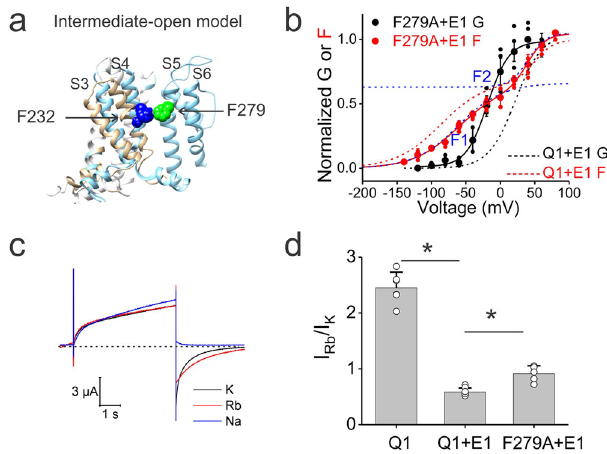
Fig. 4 F279A also allows KCNQ1/KCNE1 to open in the intermediate S4 state. a Overlay of an NMR VSD structure (gray) (PDB: 6MIE) and a cryo-EM structure (blue) (PDB: 6UZZ) of KCNQ1 channels. The NMR structure was suggested to be in the intermediate state and the cryo-EM structure was suggested to be in the fully activated state. F232 (blue) in S4 is close to F279 (green) in S5 in the intermediate VSD conformation. Only S3, S4, S5, and S6 are shown for clarity. b Voltage dependence of currents (black) and fl uorescence (red) from KCNQ1/KCNE1 (dashed lines for comparison) and KCNQ1-F279A/KCNE1 (circles) channels. F1 and F2 indicate the fi rst and second fl uorescence components from KCNQ1- F279A/KCNE1 channels (blue dashed lines). N is shown in Supplementary Table 1. c Current traces from oocytes expressing KCNQ1-F279A/KCNE1 channels under high external K + (black), Rb + (red), and Na + (blue) concentration in response to voltage protocols indicated in Fig. 3. The dashed line indicates zero currents. d Comparison of measured tail Rb + /K + ratio from the KCNQ1 ( n = 6), KCNQ1/KCNE1 ( n = 8) and KCNQ1-F279A/ KCNE1 ( n = 5) channels. Data are shown as mean ± SEM, * P < 0.05. P = 4.09349E-10 between KCNQ1 and KCNQ1/KCNE1 channels. P = 0.00015 between KCNQ1/KCNE1 and KCNQ1-F279A/KCNE1